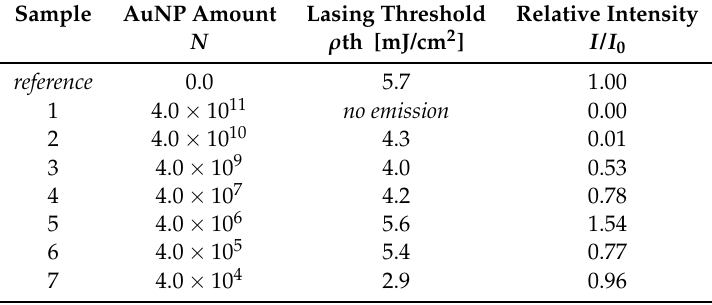
Table 1. Random lasing properties from AuNPs, Rh6G doped PVA layers, where Rh6G:PVA ratio is equal to 2.0% ( w / w )